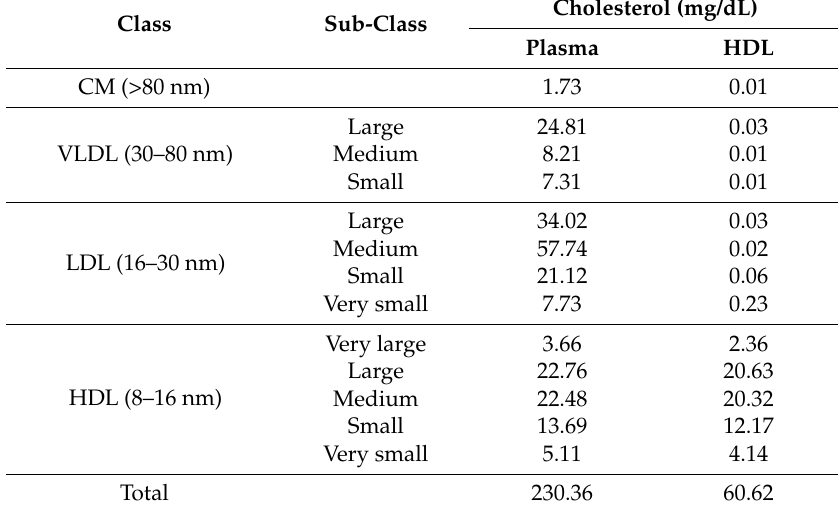
HDL was isolated from the plasma of a healthy subject by the use of the dextran sulfate-Mg 2+ precipitation method. HDL, high-density lipoprotein; LDL, low-density lipoprotein; VLDL, very low-density